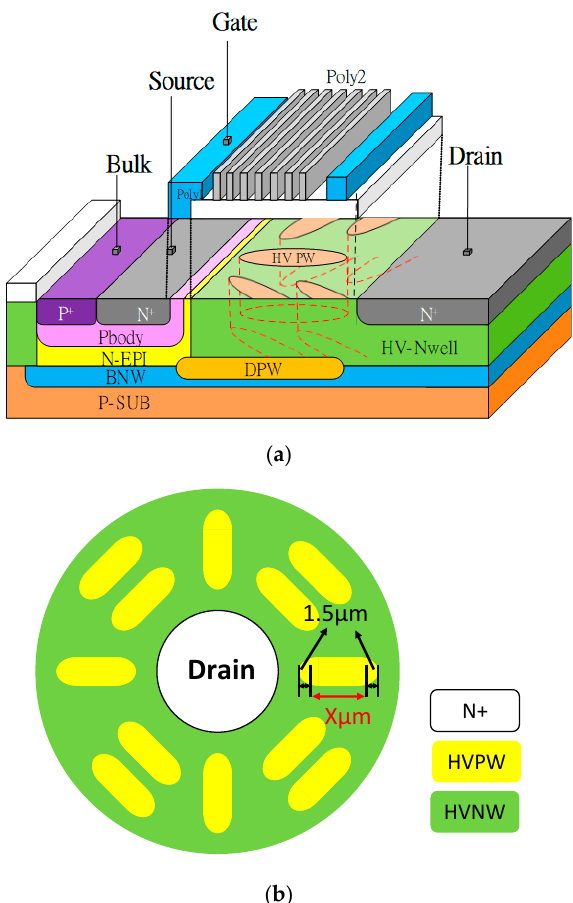
Figure 4. ( a ) 3-D structure and ( b ) drain region magnified diagrams of the UHV 300 V LDMOS (type-M8) with symmetrical eight-zone SJs in the drain region.